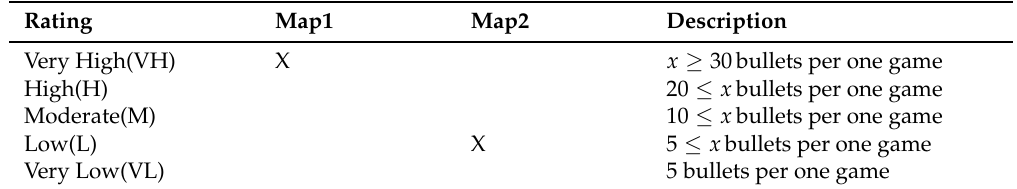
Table 1. The Vulnerability (Vul) value for both Map1 and Map2 .